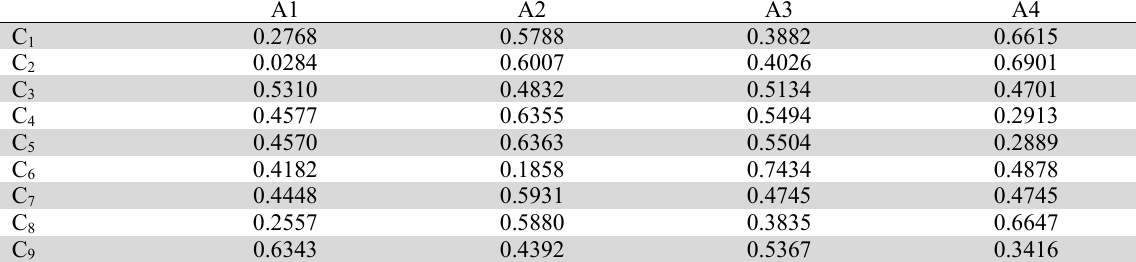
Normalised decision matrix for lighting technologies